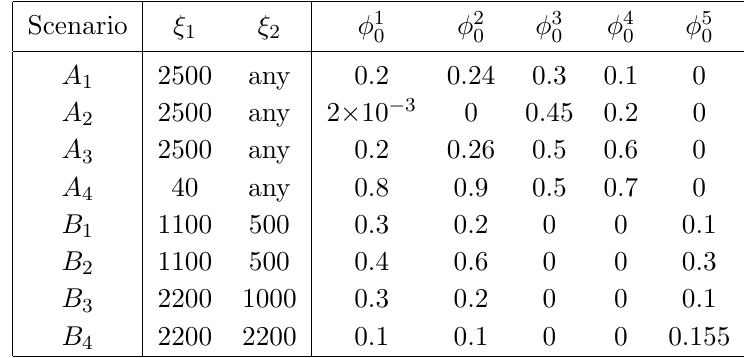
Table 1. Initial conditions (in units of M Pl ) for trajectories with successful in(cid:13)ationary scenarios, CP-odd Higgs boson mass m A = 200 GeV. The SU(2) and U(1) gauge couplings are g 1 = 0 : 36 and g 2 = 0 : 65.